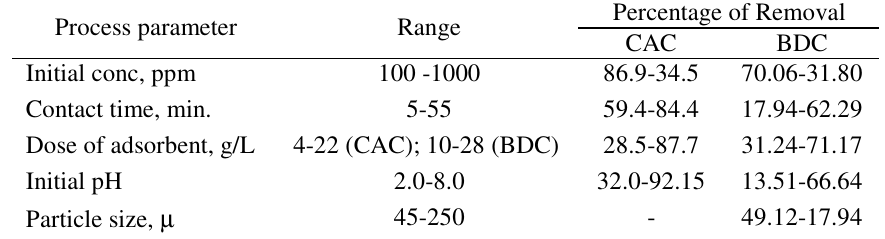
Table 1 . Effect of initial concentration for the extent of removal of lead(II) ions by CAC and BDC at 30 ° C